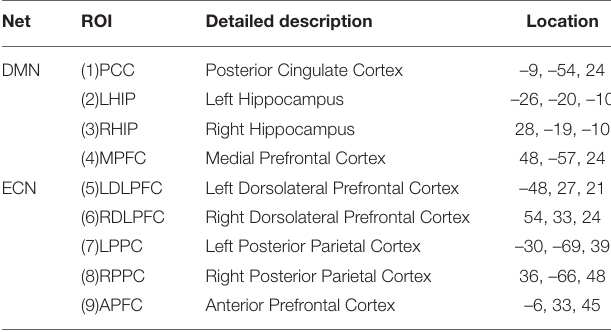
TABLE 9 | The ROIs of DMN and